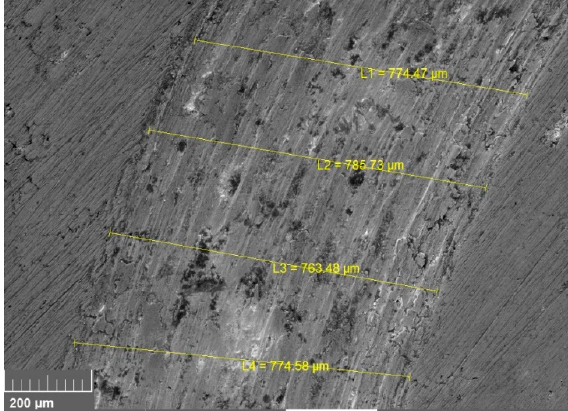
Figure 7. SEM micrographs Pin on disk wear tracks of NiTec coatings deposited at 11.04 SCFH.